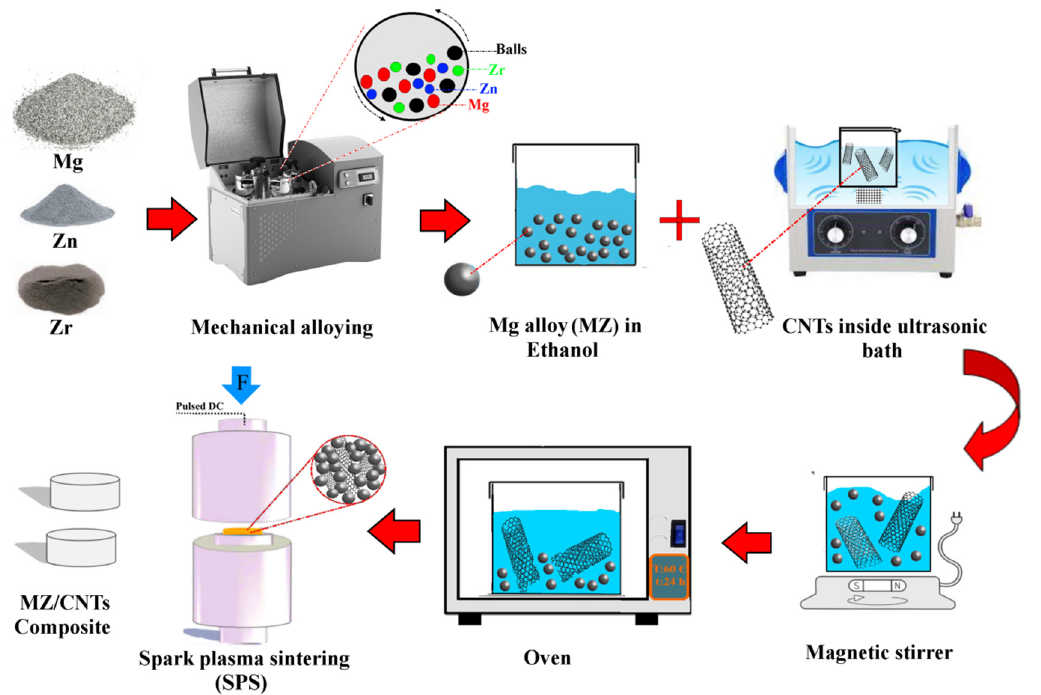
Figure 1. Illustration of the process of MZ/ CNTs composite preparation using SPM and SPS